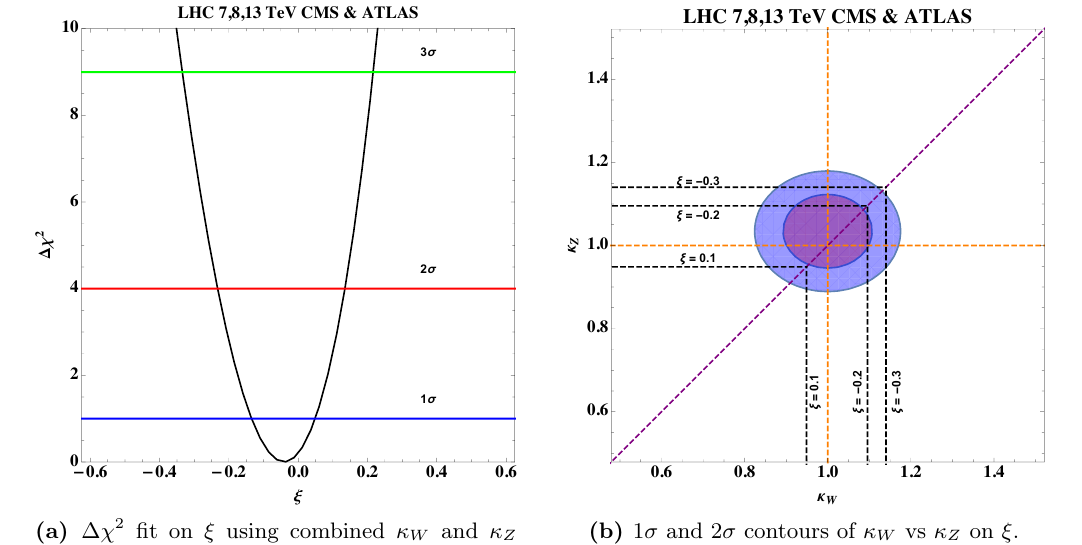
(a) (cid:1) (cid:31) 2 (cid:12)t on (cid:24) using combined (cid:20) W and (cid:20) Z from the LHC. Figure 4. Present model-independent bound on (cid:24) from HVV signal strength measurements at the LHC. From the low-energy perspective, (cid:24) could be either positive (for a compact coset G=H ) or negative (for a non-compact coset G=H